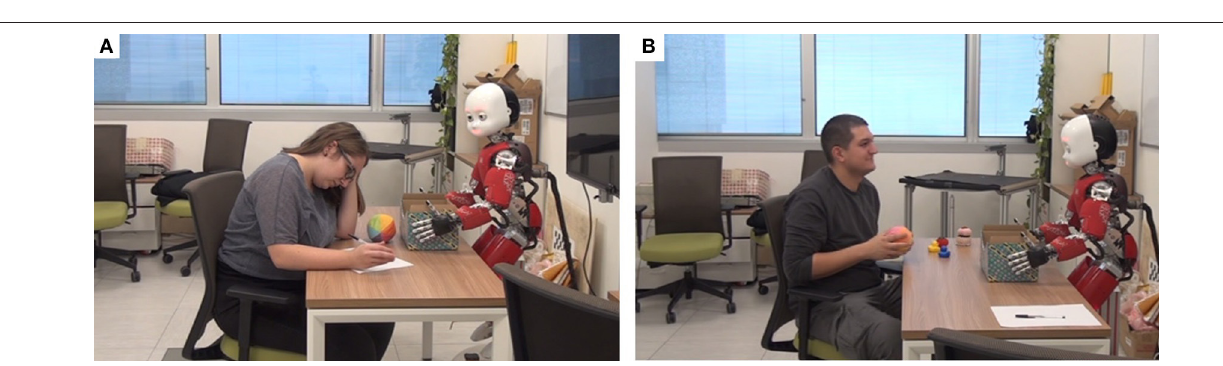
FIGURE 7 | Participants in interaction with iCub. (A) Participant working on the pollinator puzzle. (B) Participant interacting with iCub. Informed consent of participants has been obtained for the use of their